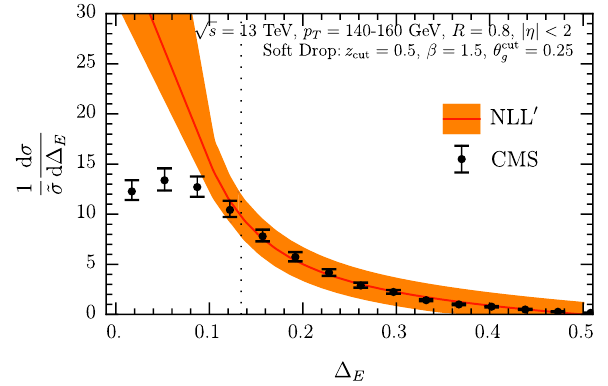
Figure 20 . Comparison of our theoretical calculation for soft drop and the preliminary CMS data of ref.